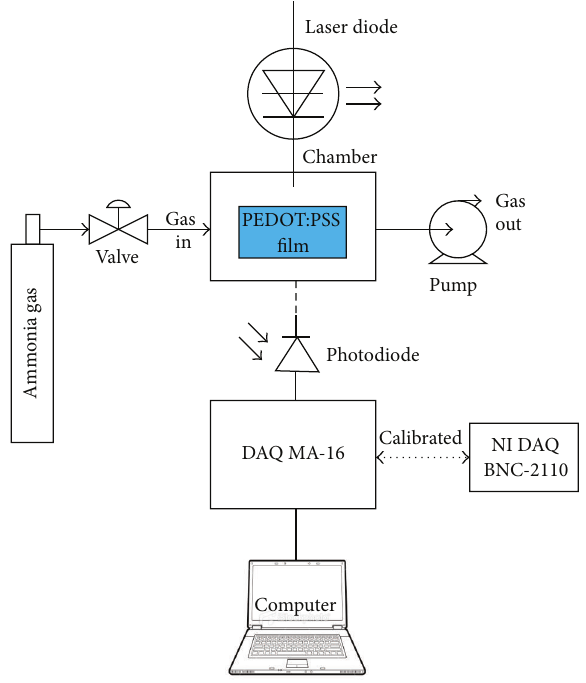
Figure 2: Experimental setup of optical measurement system of ammonia gas sensor.